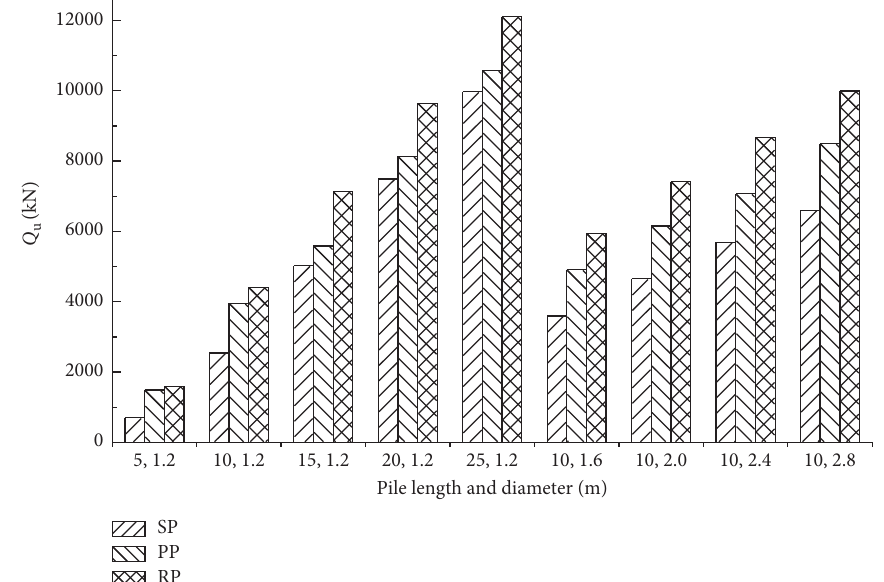
Figure 19: Ultimate bearing capacity of piles with different length and